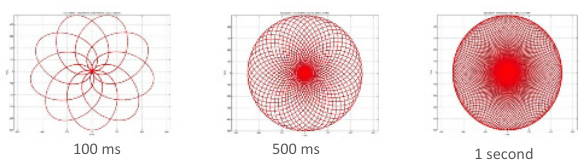
Figure 2: Sample Scan